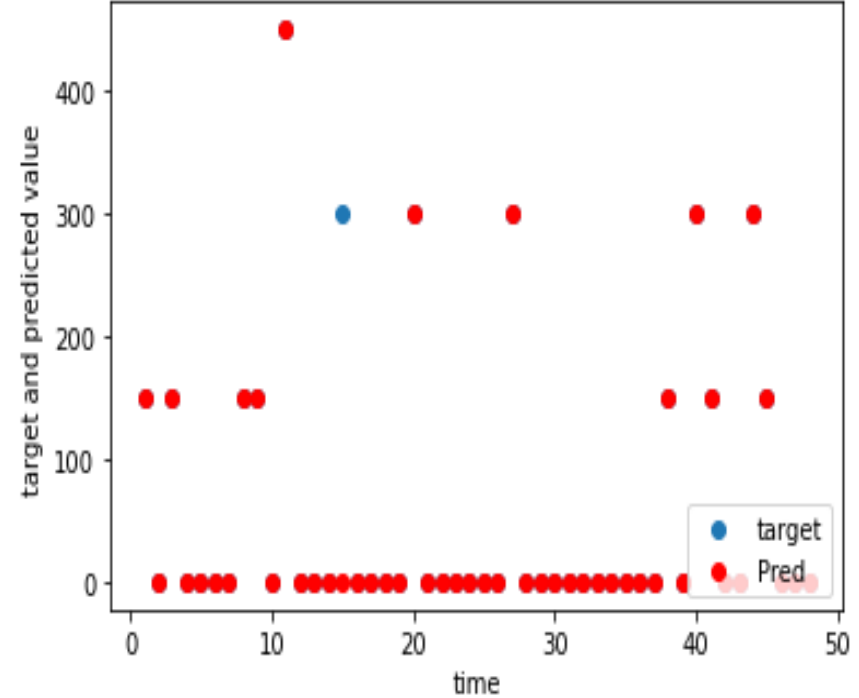
Figure 5. Charging demand prediction of a weekday for Matinkylä (M).